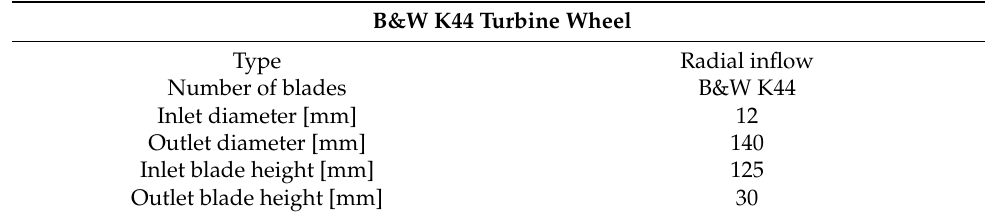
Table 1. The parameters of B&W K44 turbine wheel.